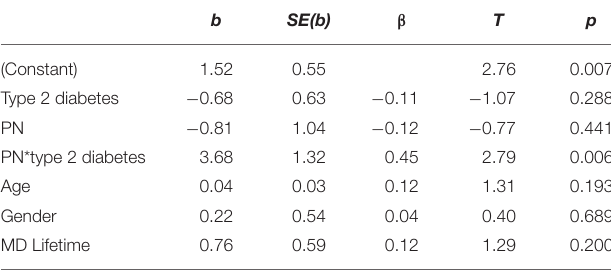
TABLE 2 | Regression on change in self-reported tension by physical neglect, R 2 =